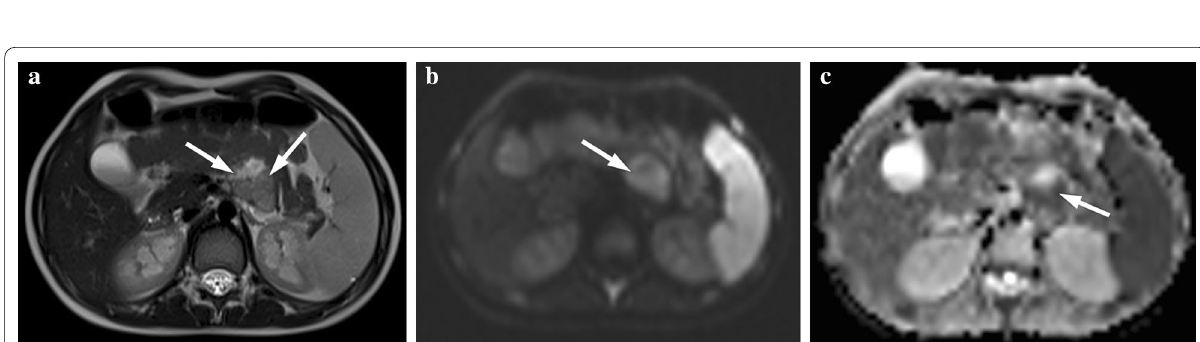
Fig. 14 a, c A 9-year-old girl was admitted to the pediatric emergency department with complaints of black stool and fatigue. She had several admissions to various gastroenterology departments during the last 2 years due to recurrent melena and fatigue. In the laboratory tests; Hb was 7.8 gr/dL (normal range 11.7–15.5 gr/dL) and ferritin was 8.3 ng/mL (normal range 20–336 ng/mL). Meckel’s diverticulum scintigraphy was normal. Esophagogastroduodenoscopy and ileocolonoscopy showed a normal appearing mucosa. Abdominal US was normal. a Axial T2-weighted MRI shows heterogeneous mass with intratumoral cystic portion at proximal jejunum (arrows). b Diffusion-weighted image (b apparent diffusion coefficient (ADC) map show diffusion restriction of solid portion of the tumor (arrows). Segmental resection was performed